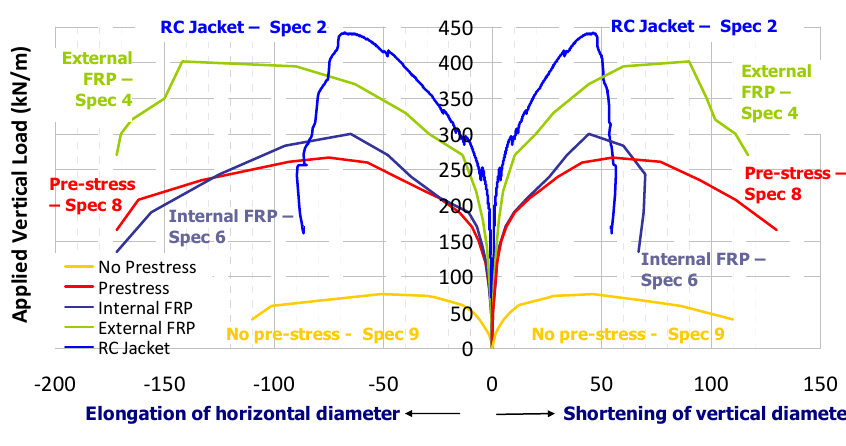
Figure 11. Experimental set ‐ up for testing the PCCP pipe specimens under a three ‐ edge bearing loading arrangement.